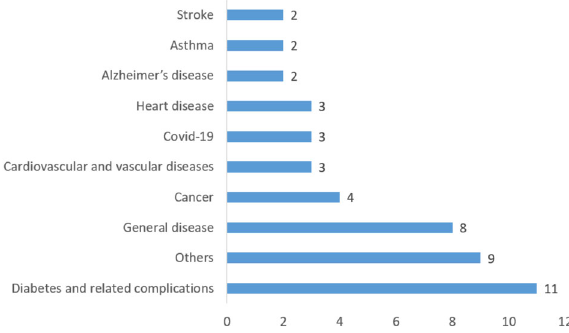
Fig. 5 Distribution of diseases